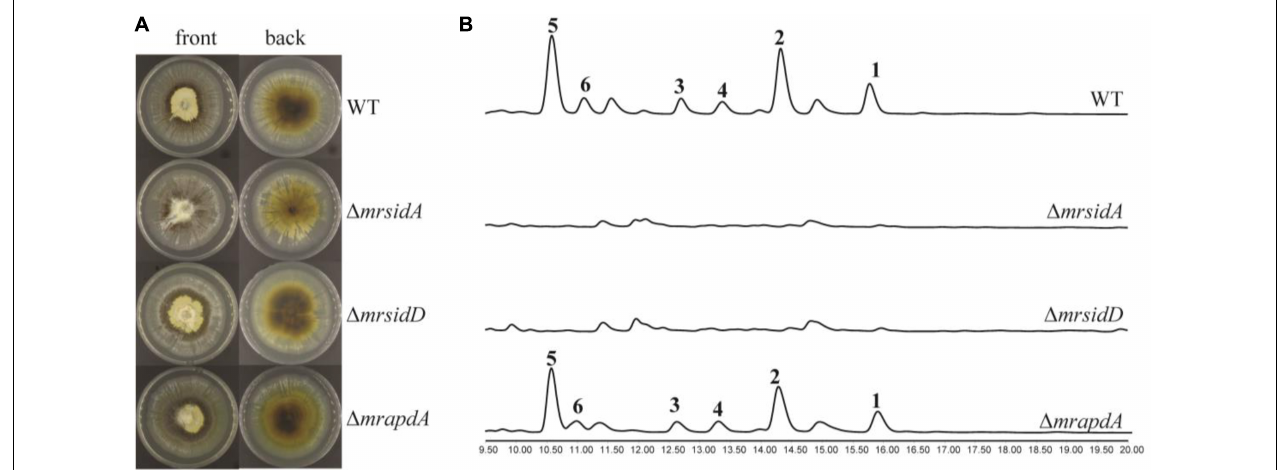
FIGURE 3 | Functional characterization of siderophore biosynthetic genes in M. robertsii . (A) Growth phenotypes of M. robertsii wild-type and mutants. 10 4 / mL conidia of the respective strain were point inoculated on SDAY plates and incubated for 7 days at 25 ◦ C; (B) HPLC traces of the extracts of wild-type and mutants in iron deficiency condition, UV absorption was monitored at 210 nm. 10 4 / mL conidia of the respective strain were point inoculated on AMM-Fe medium and incubated for 10 days at 25 ◦ C on a rotary shaker at 150